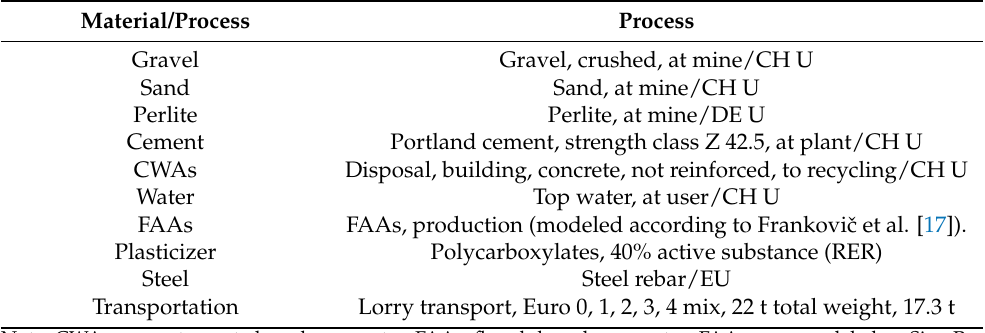
Table 8. Production stage: data input (Ecoinvent v3.2, SimaPro v9.1, 2019) for modeling life-cycle inventory (LCI) for Cases 1–4.